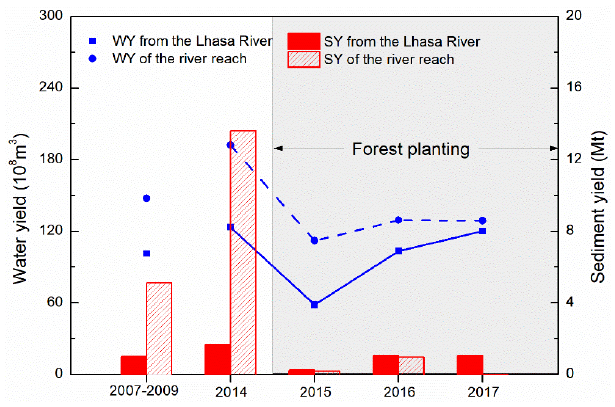
Figure 3. Monthly precipitation, discharge and sediment loads at the Nugesha and Yangcun Stations in the periods of 2007–2009 and 2014–2017; panels a . and b . show the monthly precipitation at Nugesha and Yangcun Stations, respectively; panels c . and d . show the monthly discharge and sediment load at Nugesha and Yangcun Stations, respectively.